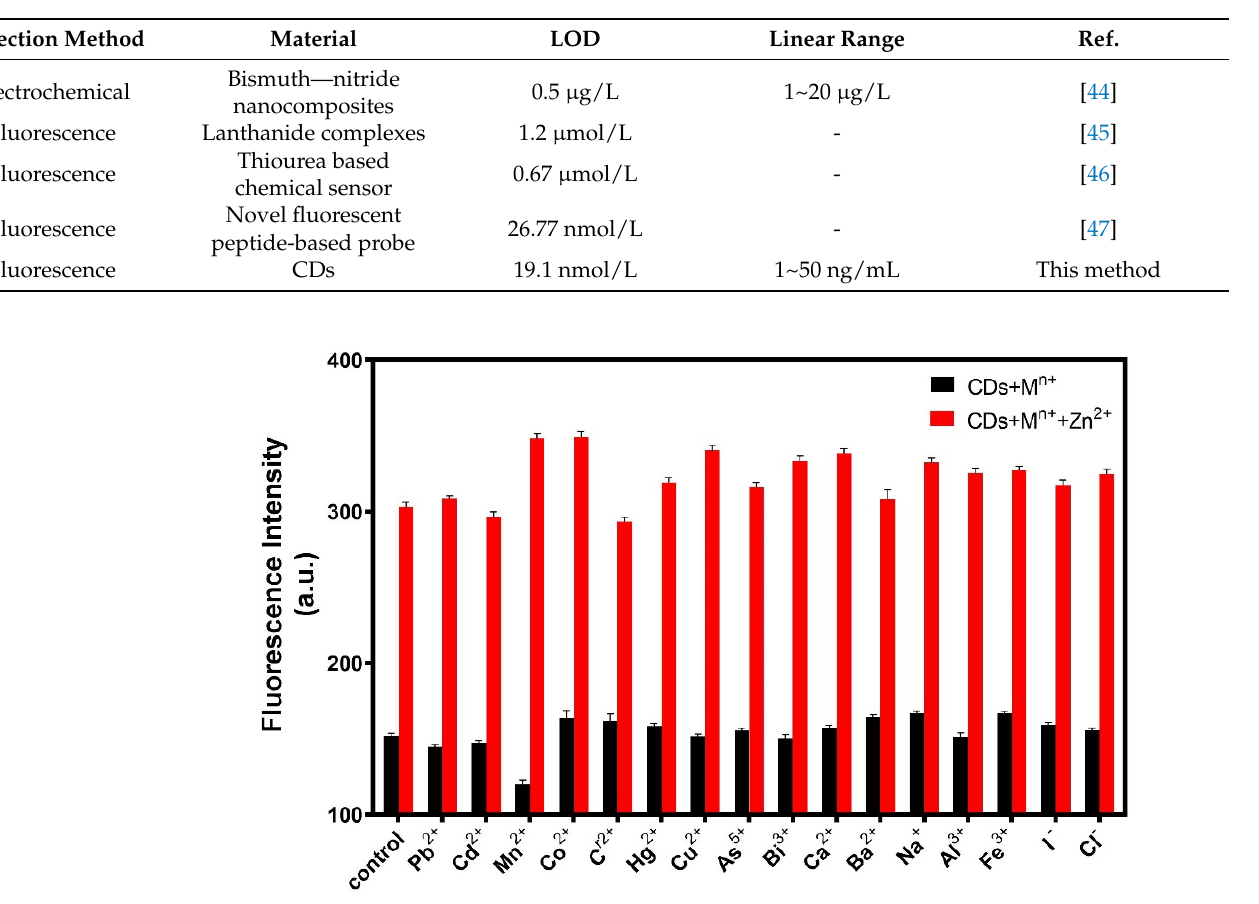
Table 2. Comparison between this method and other methods for the detection of Zn 2+ . Figure 7. Fluorescence responses in the λ Em = 650 nm of the R-CDs upon the addition of different concentrations of Zn 2+ ( A ) and linear correlation of fluorescence intensity versus the concentrations of Zn 2+ in the range from 1 ng/mL to 50 ng/mL ( B ).